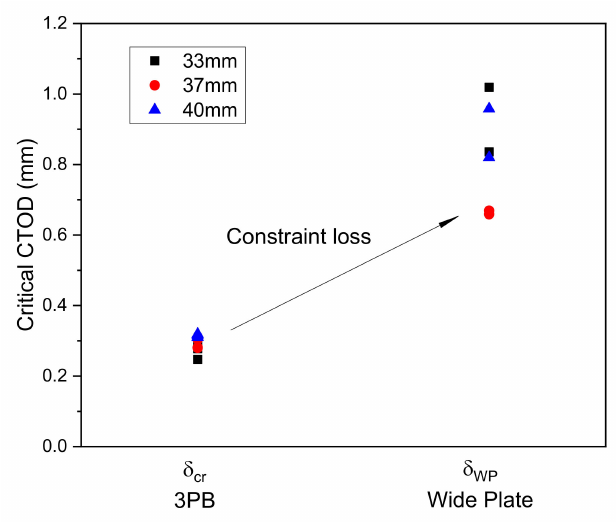
Figure 3. Comparison of CTOD values determined using 3PB and WP tests.